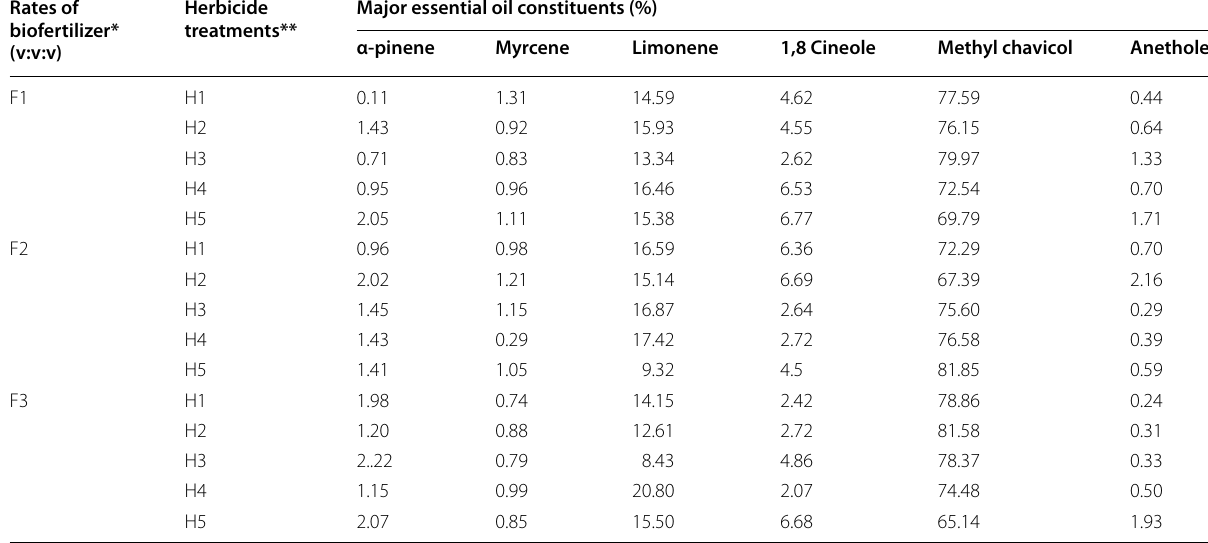
* The three biofertilizer rates F1: 1:1:1, F2: 2:1:1 and F3: 1:1:2 (v/v/v) from the highly efficient bacterial strains of; atmospheric nitrogen fixation, phosphor dissolving and potassium solubilizing, respectively. **Herbicides treatments; (H1) untreated check without weed removal by hand as control treatment, (H2) untreated check with weed removal, (H3) pendimethalin at reduced rate;812 g a.i. ha − 1 , as pre-emergence (after sowing and before irrigation), (H4) fluazifop-p butyl at the recommended rate; 450 g a.i. ha − 1 as post-emergence (30 days after sowing) and (H5) a combination of sequential application of pendimthalin at the half rate recommended rate Table 6 Recovery percentages of fluazifop and pendimethalin Herbicide